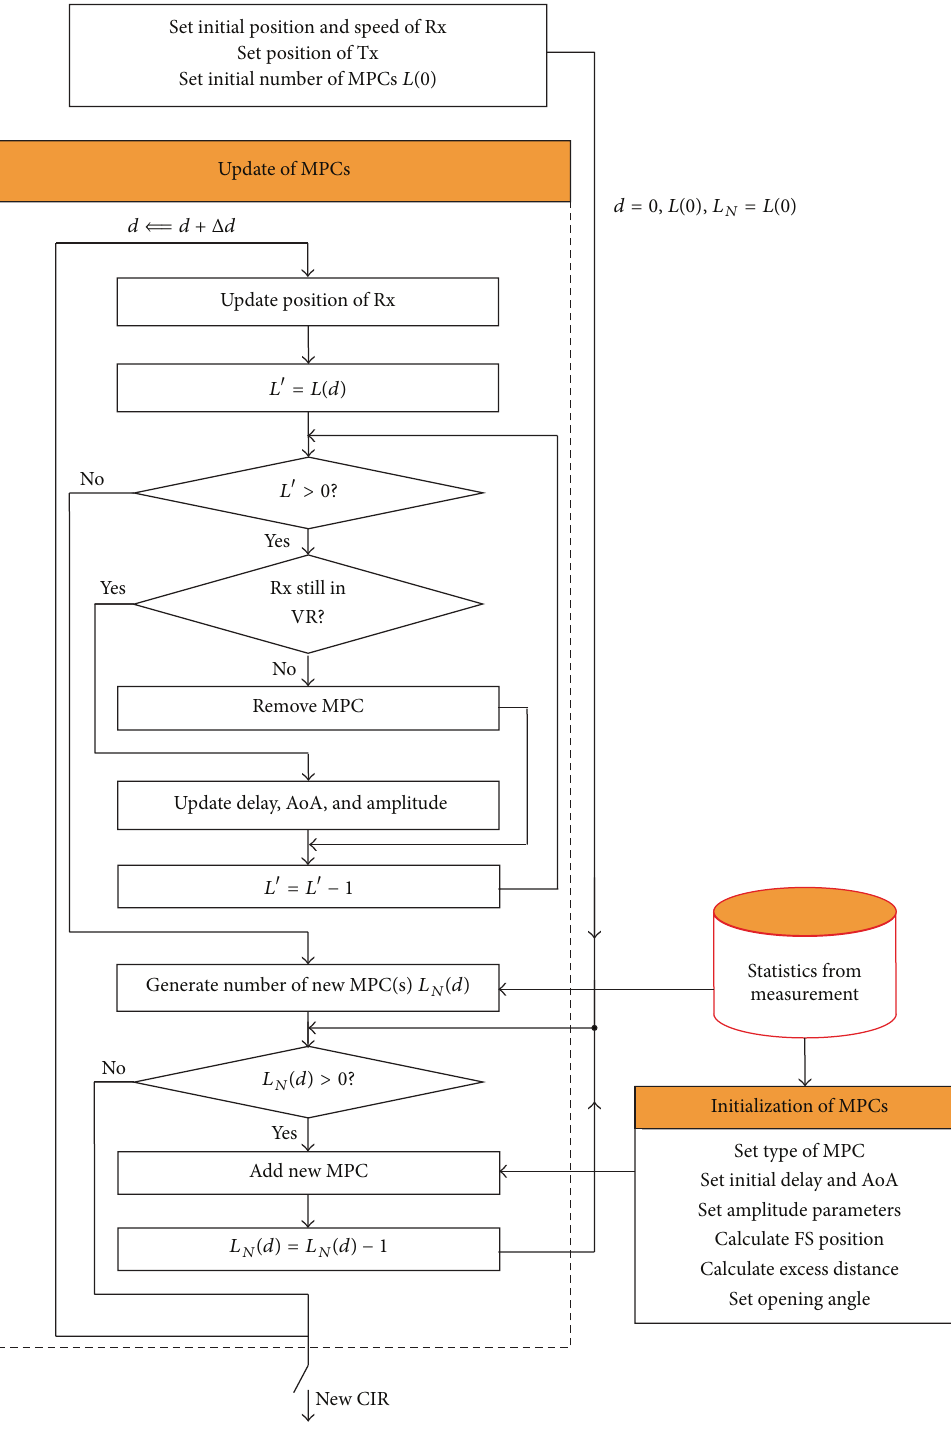
Figure 16: Flow chart of channel